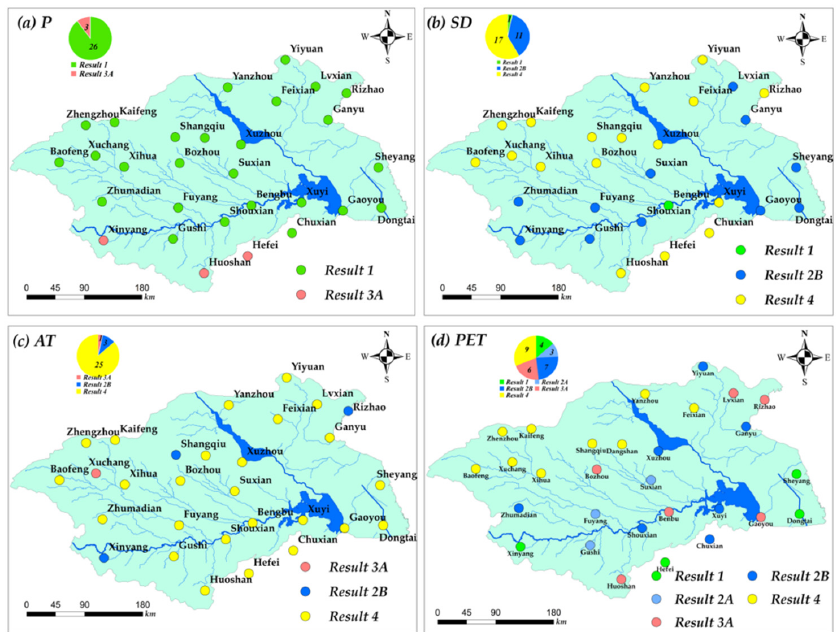
Figure 11. Trend test results for P, SD, AT, and PET series of the HRB. (Note: the results for the MMK test and OW operation are the same).